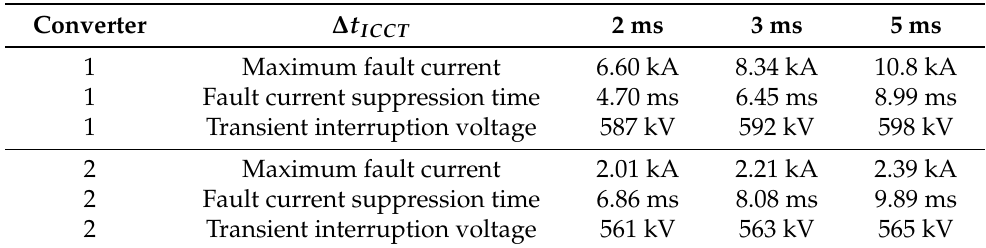
Figure 17. Current and voltage for the DC circuit-breakers of the negative poles of Converter 1 (green) and Converter 2 (red) with different internal current commutation times ∆ t ICCT , dashed line for ∆ t ICCT = 2 ms, solid line for ∆ t ICCT = 3 ms and dotted line for ∆ t ICCT = 5 ms. Table 11. Electrical characteristics of the circuit-breakers’ operation for different internal current commutation times